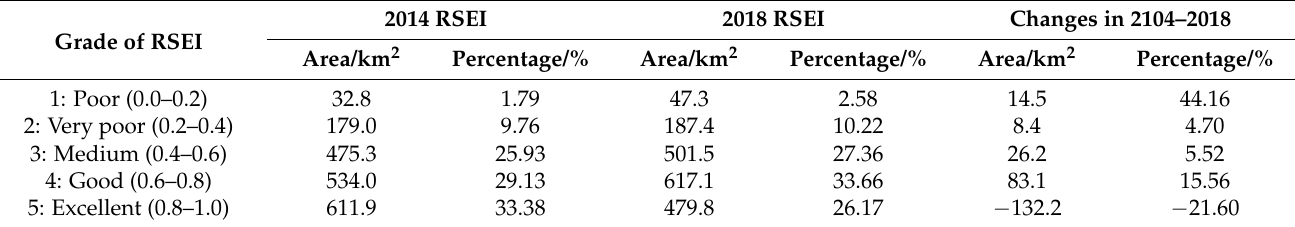
Figure 2. RSEI of Sanya in 2014 and 2018. Table 4. Statistics of RSEI grades in 2014 and